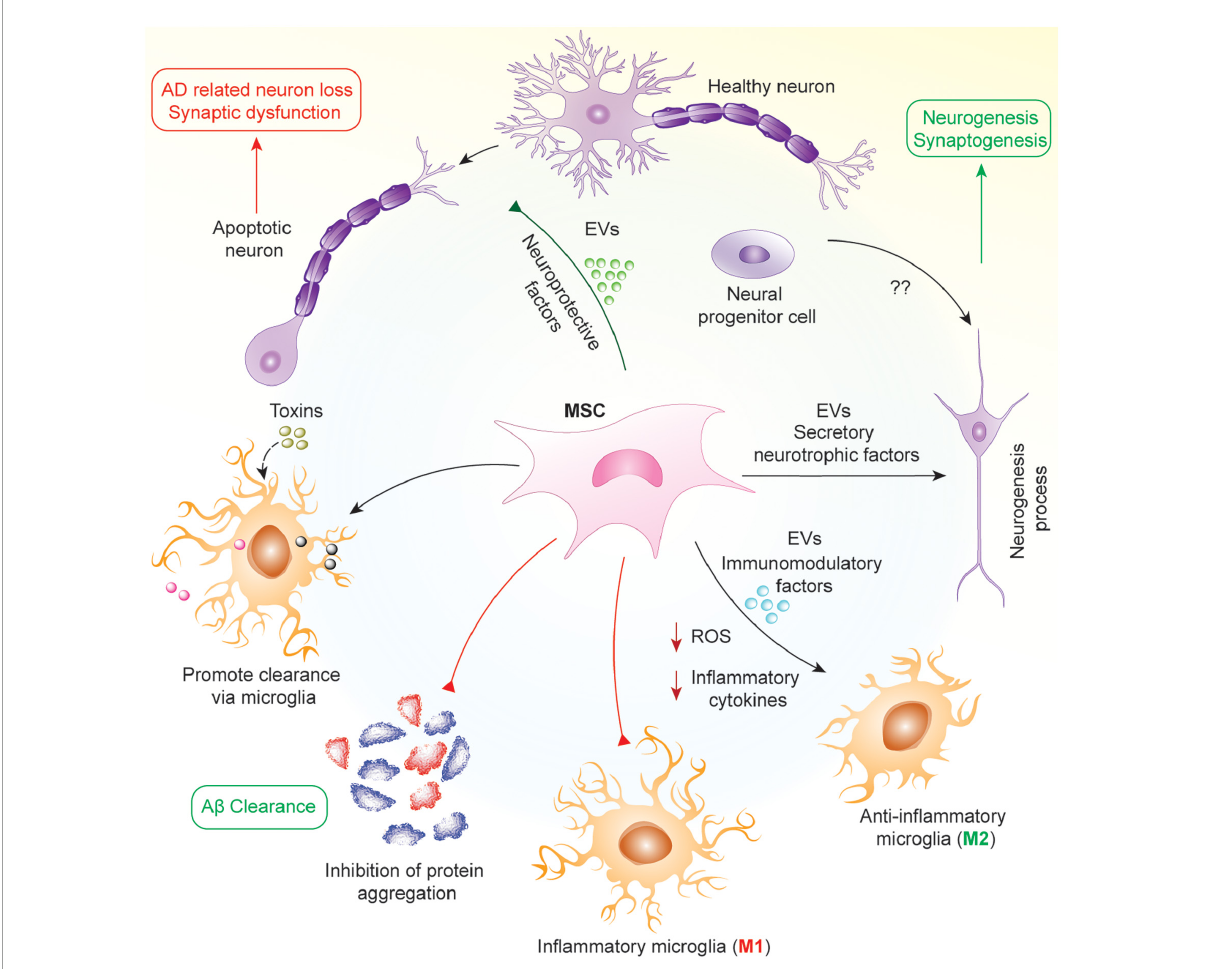
FIGURE1 Mechanism of protective effects of MSCs in AD. In AD, neuronal loss and synaptic dysfunction occur due to the apoptosis of neurons by accumulating different proteins such as A β and hyperphosphorylated tau. MSCs work in pleiotropic mechanisms in this pathology to attenuate AD via secretion of various neuroprotective and neurotrophic factors such as VEGF, GDNF, BDNF, and several miRNAs in soluble or insoluble form as EVs. As a result, MSCs help in the clearance of aggregated proteins by increasing microglial phagocytosis, reprogramming microglia into anti-inflammatory phenotype, attenuating oxidative stress and neuronal apoptosis, and promoting neurogenesis from neural progenitor